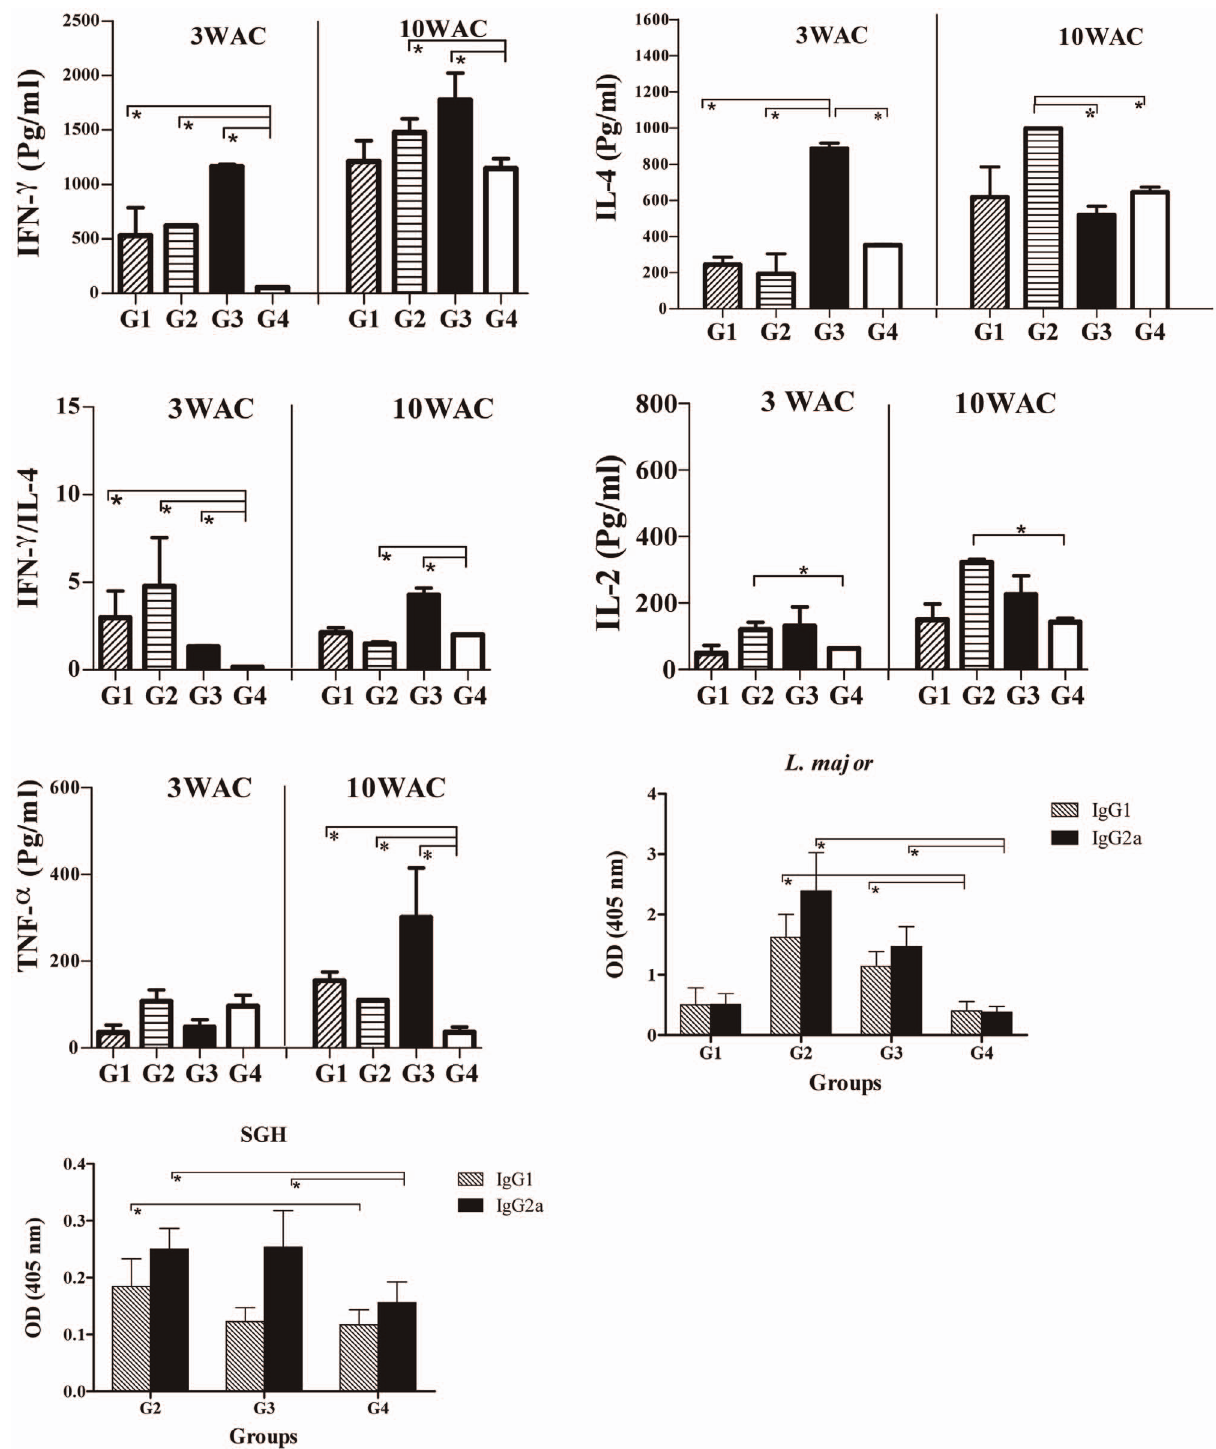
Figure 5. The immune response post-challenge in BALB/c mice vaccinated with different modalities. A–E, Cytokine production by splenocytes at 3 and 10 weeks after challenge (WAC). Single cell suspensions were prepared from splenocytes of 4 mice after infectious challenge. Cells were cultured in duplicate in the presence of freeze-thawed L. major + SGH for G2, G3 and G4 and with only L. major for G1. Culture supernatants were assayed for the level of IFN- c (A), IL-4 (B), ratio of IFN- c to IL-4 (C), IL-2 (D) and TNF- a (E) production by ELISA. Each bar represents the Mean 6 SD of 4 mice per group. The asterisk indicates the significant difference between values at the indicated time points as determined by Mann Whitney U test compared to the control group (G4). Antigen-specific antibody responses against L. major (F) and SGH (G) five weeks after challenge. Data represent the serum IgG1 and IgG2a levels of individual mice within their respective vaccination group (n=8–10). Statistical analysis was carried out by Mann Whitney U test comparing vaccination groups against G4 as control ( p , 0.05 denoted as *). Results are representative of two independent experiments. doi:10.1371/journal.pntd.0002751.g005 PLOS Neglected Tropical Diseases |